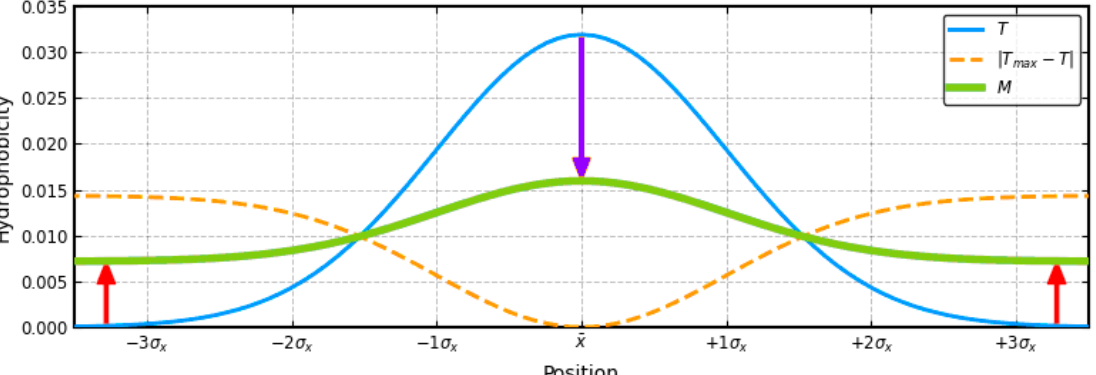
Figure 2. The functions applied in the FOD-M model in step-wise form. Blue line—globular proteins with the hydrophobicity of the form of micelle-like expressed by the 3D Gauss function. Concentration of hydrophobicity in the central part with the polar residues on the surface—hydrophobicity approach zero level— T distribution. Orange dashed line—idealized hydrophobicity distribution in membrane-channel protein—the distribution “inversed” with the lowest hydrophobicity in the central part (channel) with high hydrophobicity on the surface (contact with membrane)—( T ma x − T i ) n . Green line— consensus between 3D Gauss function and “inversed” function expressing the synergy between polar and hydrophobic environment. Red arrows—increase of hydrophobicity on the surface. Blue arrow—decrease of the hydrophobicity level in the central